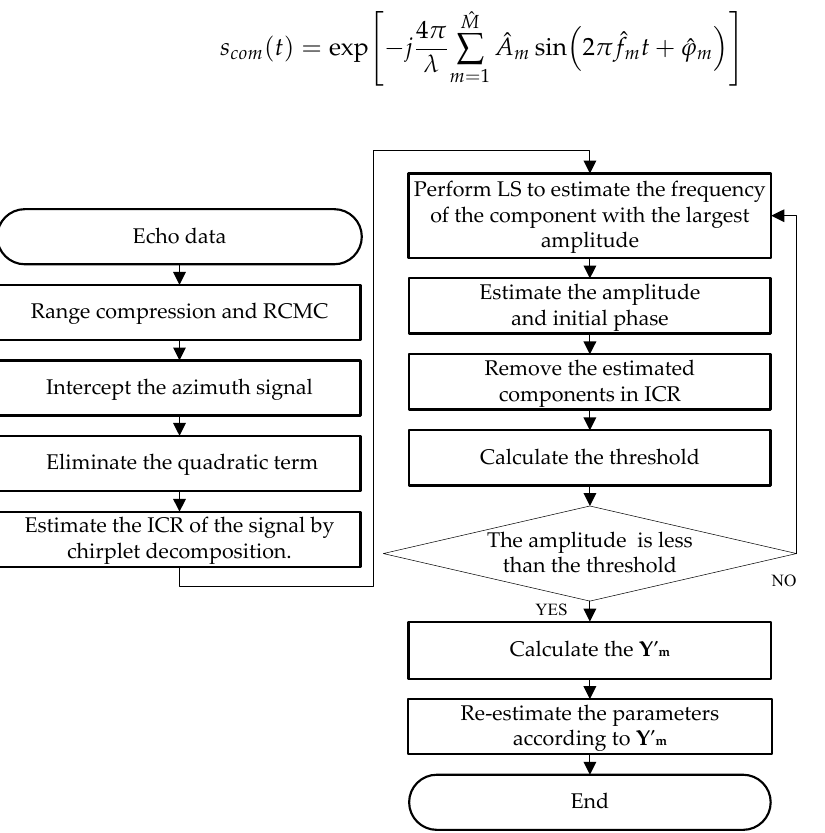
Figure 3. Flow chart of the proposed method.